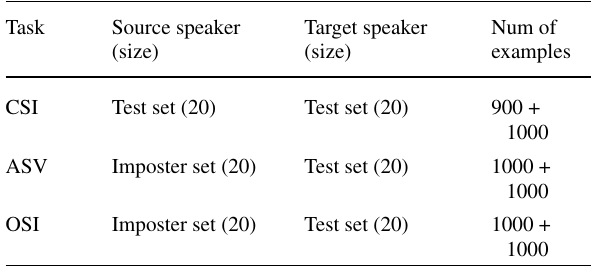
Table 2 Configuration of speakers and adversarial examples for the three tasks ( intra-gender + inter-gender in the last column)